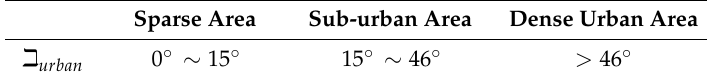
Table 1. Definition of the degree of urbanization based on (cid:105) urban